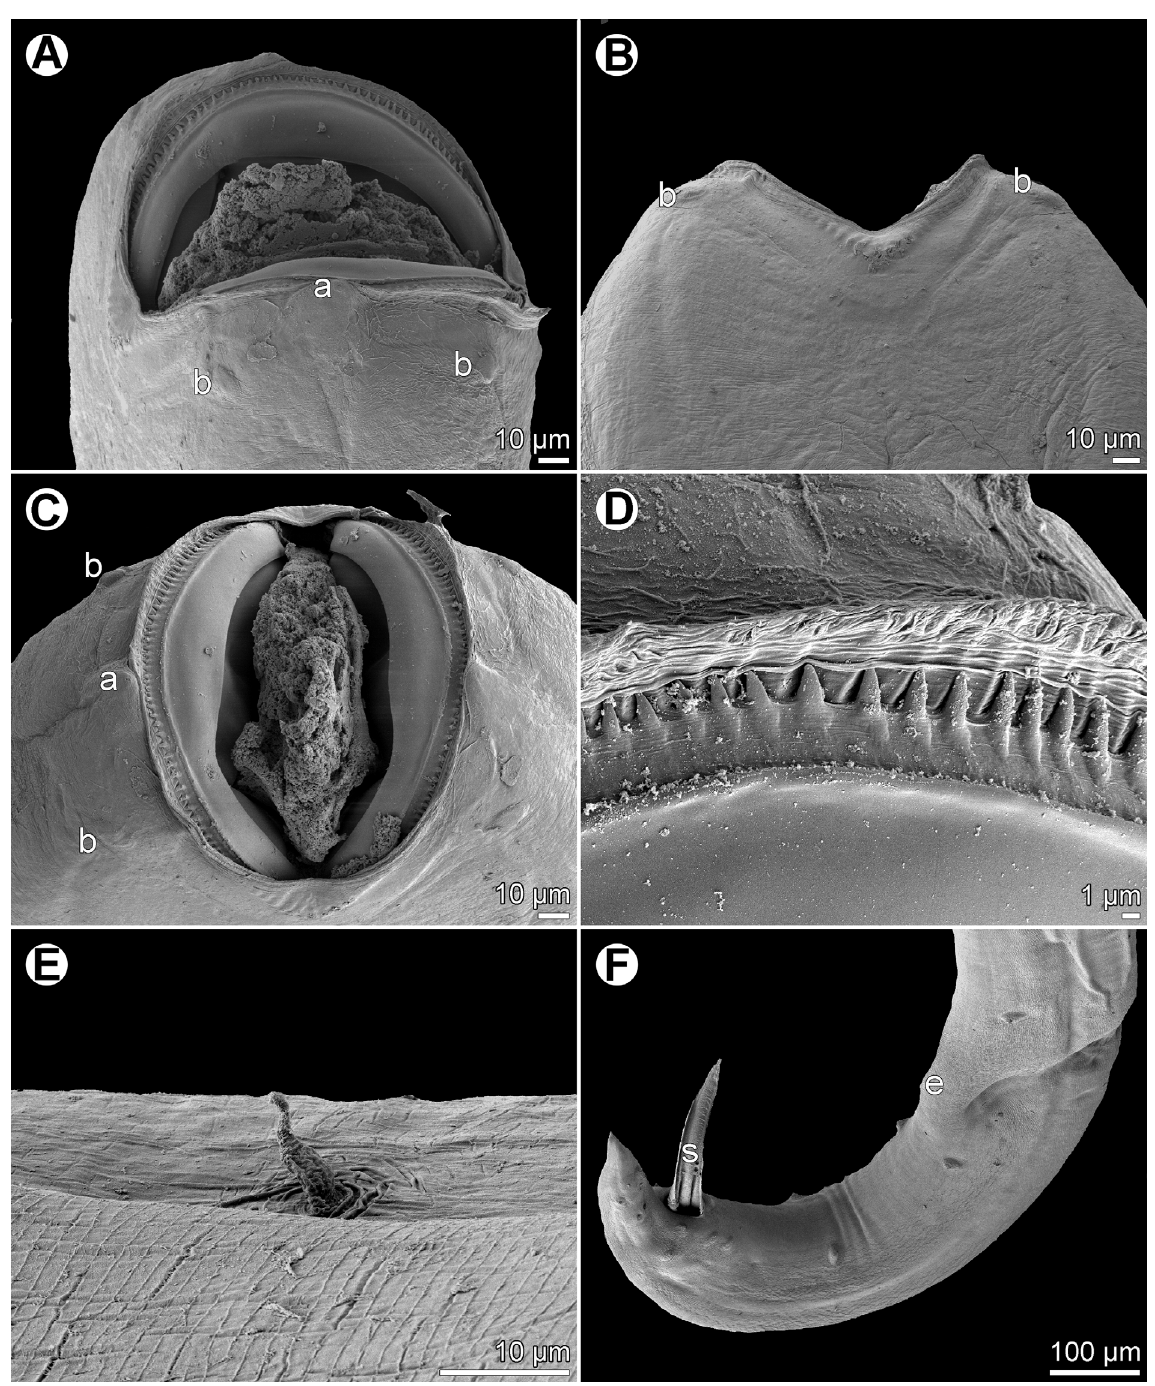
Figure 5. Cucullanus gymnothoracis n. sp., scanning electron micrographs of male. (A, B) Cephalic end, lateral and dorsoventral views, respectively; (C) same, apical view; (D) cephalic teeth; (E) deirid; (F) posterior end of body, lateral view. (a) amphid; (b) cephalic double papilla; (e) ventral sucker; (s)